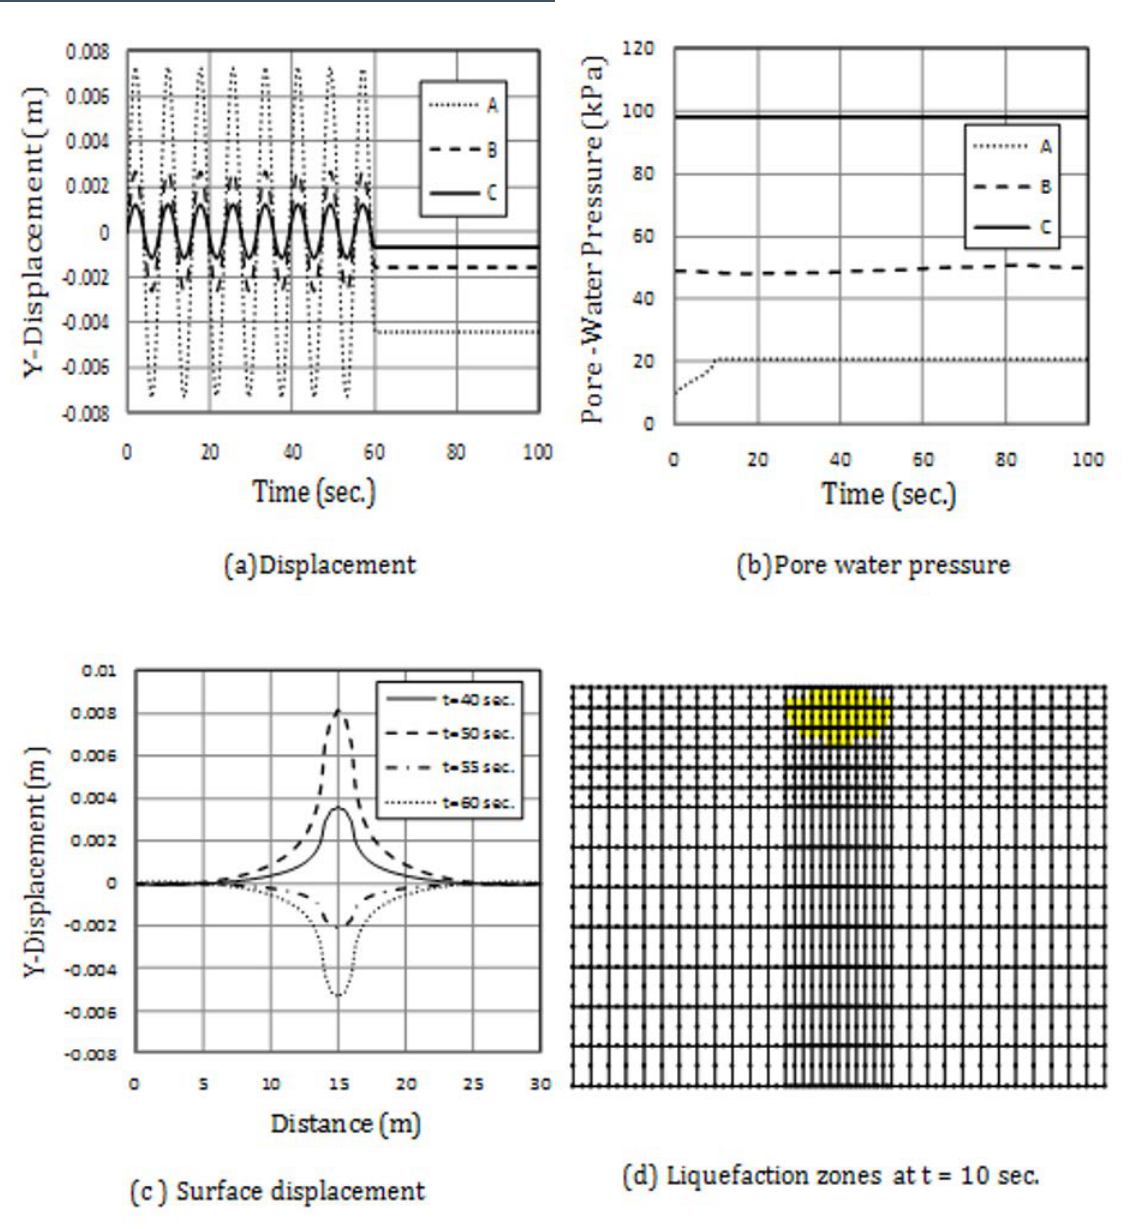
Figure 20. Dynamic response of the foundation to harmonic load, a